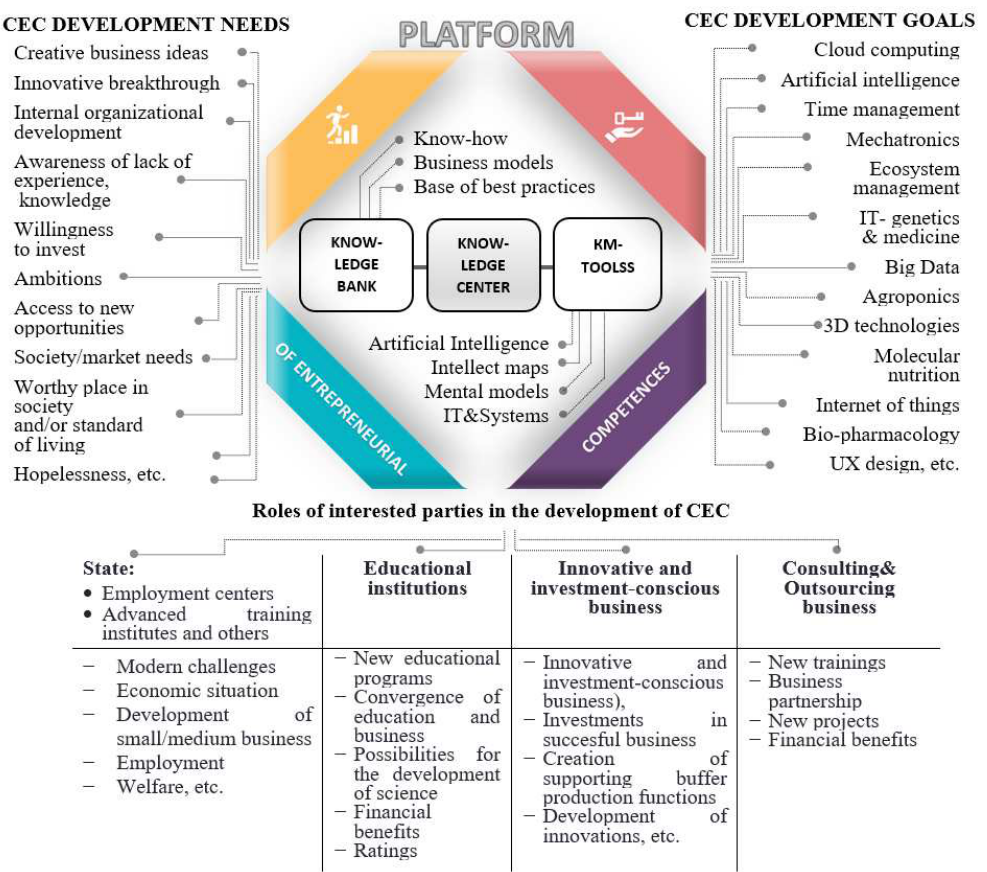
Figure 4. Platform for the development of entrepreneurial